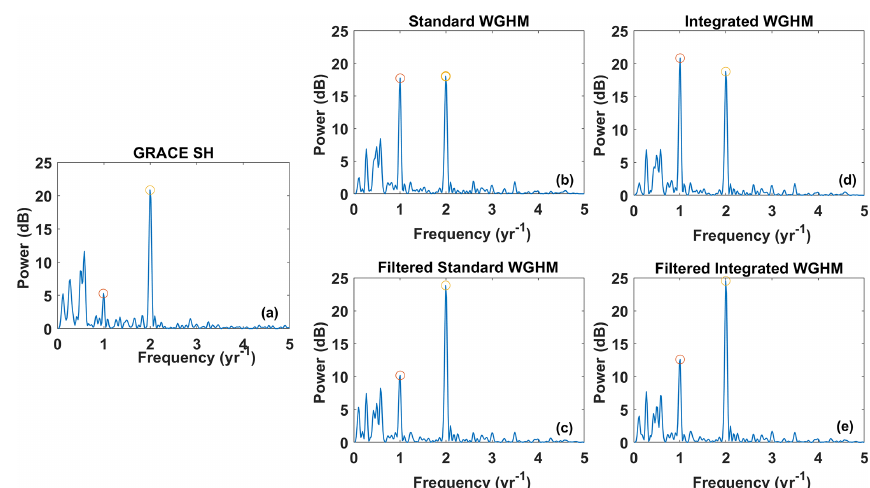
Figure 6. Lomb–Scargle periodograms for basin-averaged time series from (a) GRACE SH, (b) unfiltered standard WGHM, (c) unfiltered integrated WGHM, (d) filtered standard WGHM, and (e) filtered integrated WGHM. The peaks marked were selected as dominant for time series